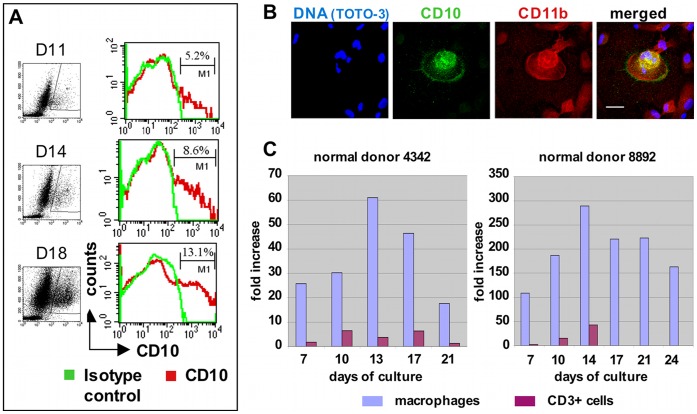
CD10 expression in cultured macrophages.(A) Flow cytometry demonstrating that SMC-derived maturing macrophages express CD10 with increasing frequency. Percentages reflect portions of maturing macrophages expressing CD10. Corresponding CD10 versus side scatter (SSC) plots with gates are shown on the left. See Table 1 for kinetics of expression. (B) Confocal microscopy images demonstrating CD10 expression on a young, EDTA-recovered nurse macrophage at D3 of IL-2 exposure. Size bar: 20 µm. (C) Expression of CD10 in macrophages and CD3+ cells recovered from primary macrophage cultures, as determined by real-time PCR. CD3+ cells were purified from the nonadherent populations using CD3+ magnetic beads. Macrophages were harvested using accutase. For each donor, the mean values obtained from uncultured CD3+ cells were subtracted from the mean values shown for CD3+ cells at each time point, and similarly, the mean values obtained from uncultured CD14+ cells were subtracted from the mean values obtained for the cultured macrophages at each time point. No values are shown for CD3+ cells for donor 8892 at days 17, 21 and 24, because too few nonadherent cells were recovered to permit CD3+ magnetic bead selection. The average percent difference between replicate reactions (including those for GAPDH) was 0.6% (donor 4342) and 0.7% (donor 8892).